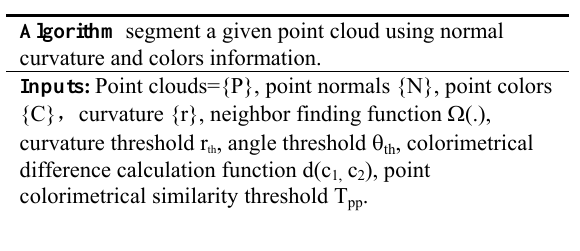
Algorithm segment a given point cloud using normal curvature and colors